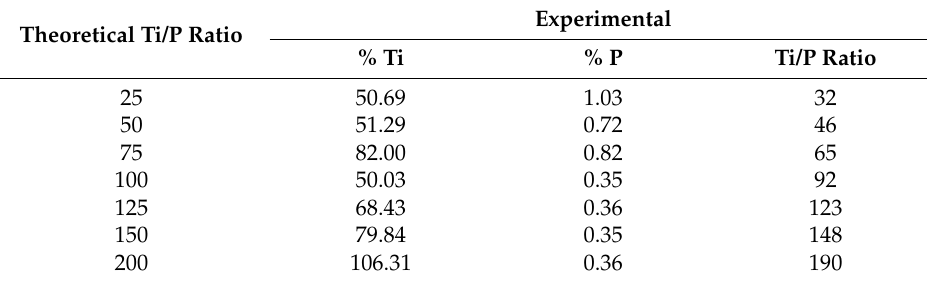
Table 2. Ti and P elemental analyses of the samples (TiO 2 ) x (VPA). Theoretical Ti/P Ratio